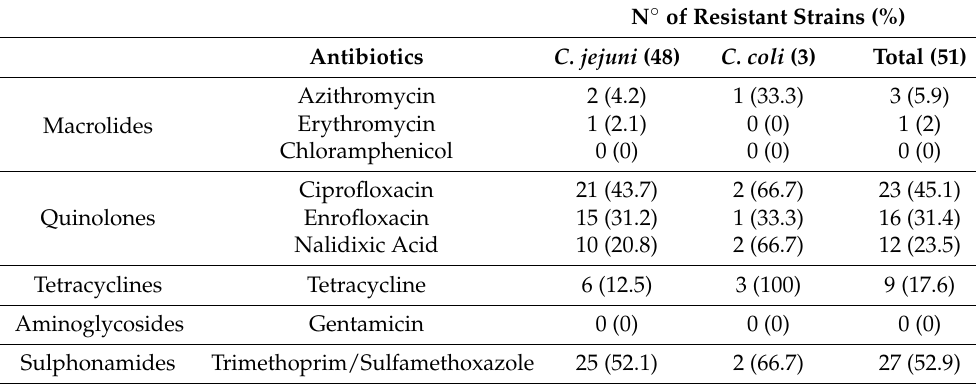
Table 8. Antibiotic resistance of Campylobacter jejuni and C. coli from wild birds.